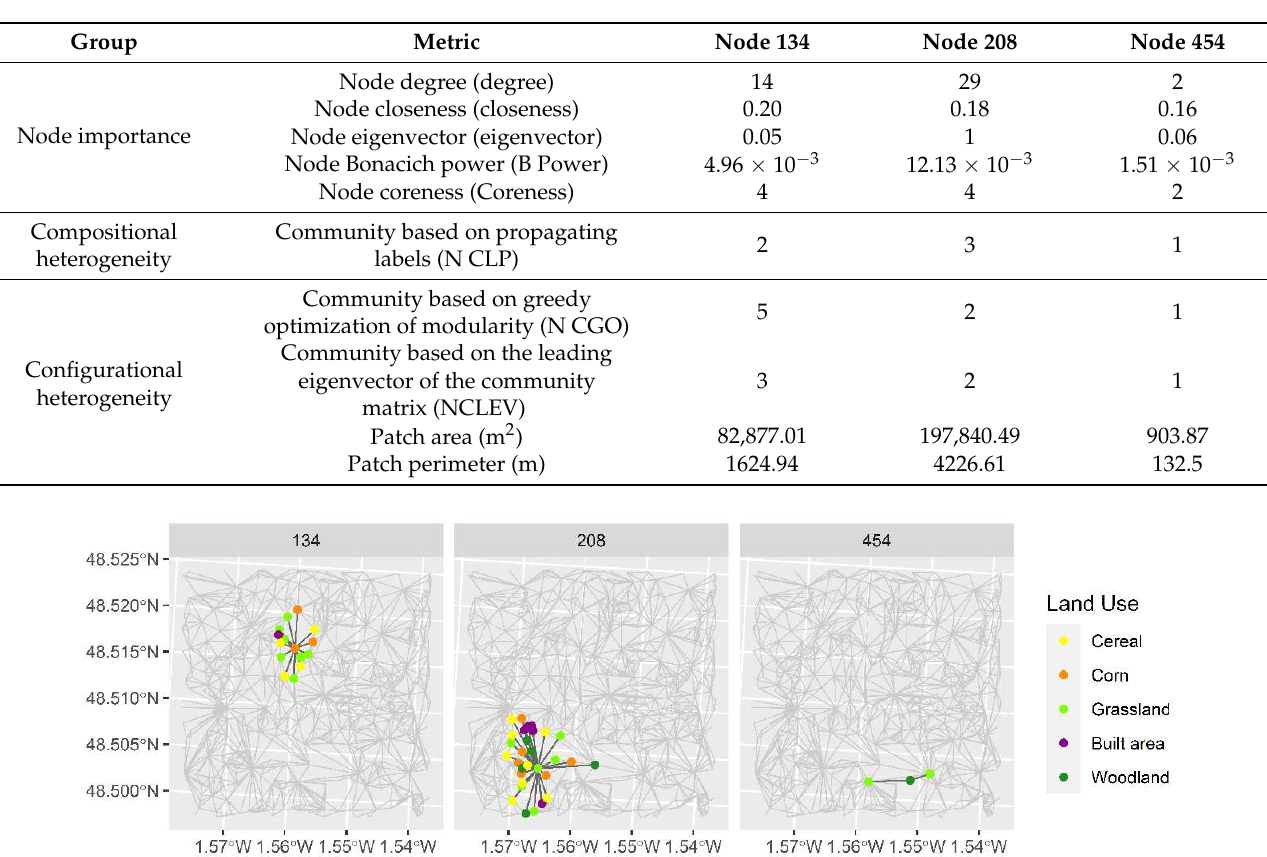
Table 5. Application of graph metrics at the local scale of landscape B in the Zone Atelier Armorique in 2010. The metrics of the three groups are given for three contrasting nodes 134, 208, and 454.